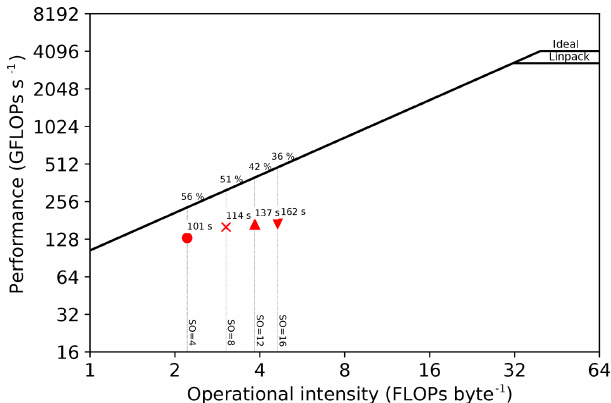
Figure 24. Roofline plots for a 1024 × 1024 × 1024 model on a Sky- lake 8180 architecture. The runtimes correspond to 1000ms of mod- eling for four different spatial discretization orders (4, 8, 12,